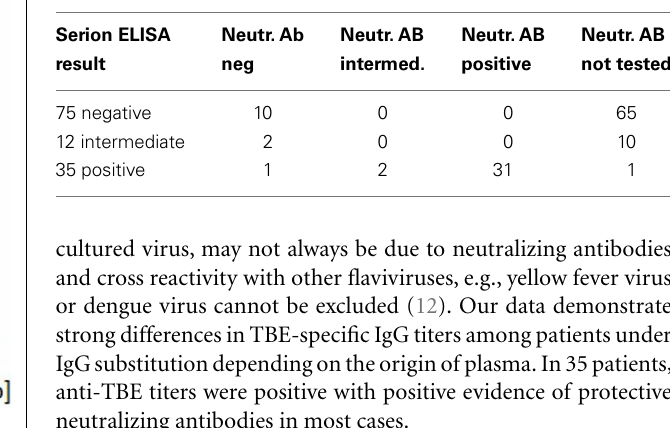
TBE-specific serum titers in patients in relation to the geographic origin of the received IgG preparation.